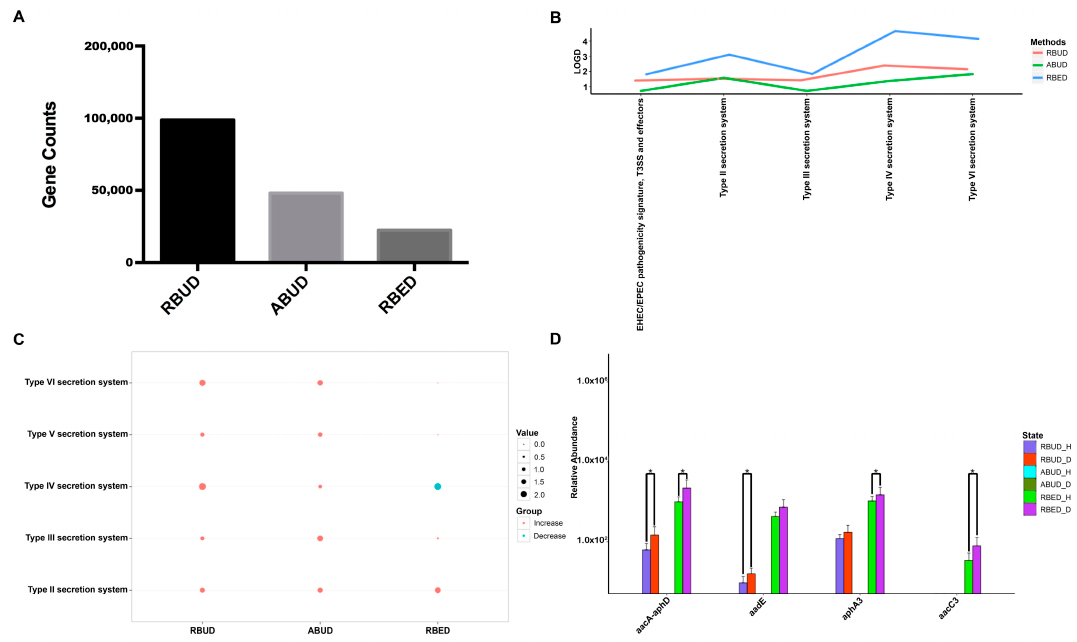
Figure 7. Enriched functions in disease samples identified by the three methods in the study case of avian colibacillosis. ( A ) The counts of the enriched genes obtained by the three methods. ( B ) The abundance changes of the pathogenic functions of bacterial secretion system in the COG database.